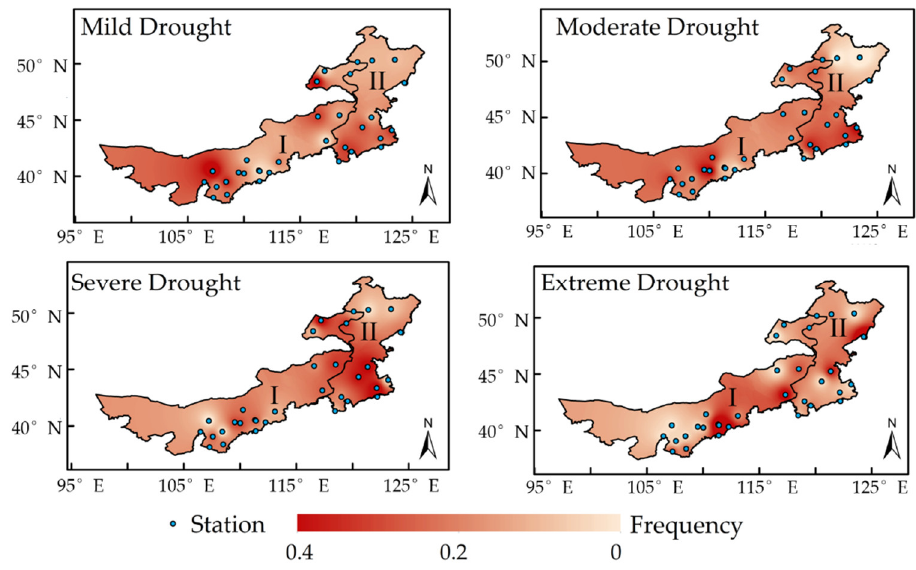
Figure 2. Distribution of the SMAPI at different drought frequencies in the Inner Mongolia Autonomous Region.